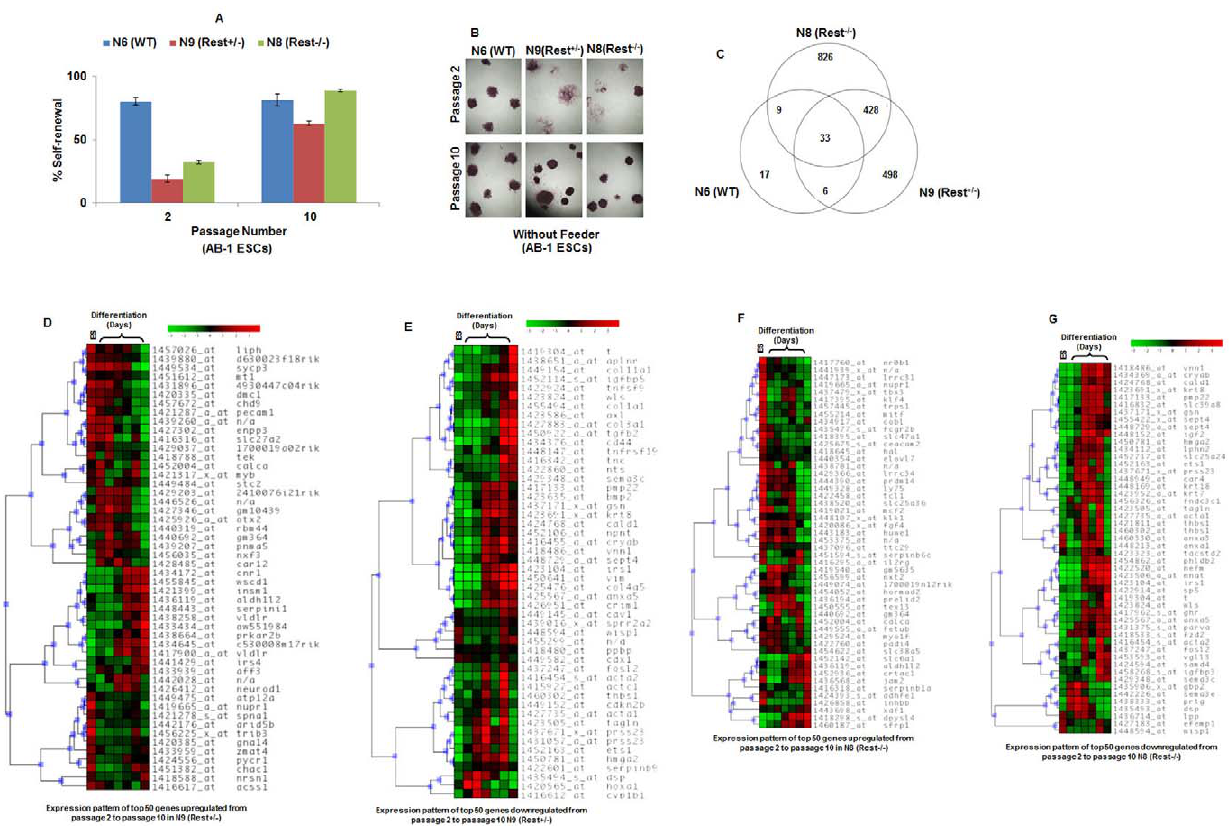
Figure 1. Rest + / 2 and Rest 2 / 2 AB-1 ESCs cultured in the absence of feeder cells show impaired self-renewal that is restored upon prolonged culture. (A, B) Alkaline phosphatase based self-renewal assay shows that the self-renewal efficiency of the N9 (Rest + / 2 ) and N8 (Rest 2 / 2 ) ESCs was significantly lower than that of the parental AB-1 ESCs at passage 2 but not at passage 10. (A) quantification of self-renewal assays. (B) representative pictures of colonies from self-renewal assays. The numbers under the lines show p-values (n=3). Error bars are standard error of means. Cells were cultured in absence of feeder cells and in presence of LIF. (C) Venn diagram showing comparison of genes that showed a significant change in expression during the transition between passage 2 and passage 10 by genome-wide expression profiling. N9 (Rest + / 2 ) and N8 (Rest 2 / 2 ) cells showed significant changes in gene expression (N9 , 965 and N8 , 1296) compared to WT cells ( , 65). (D, E, F and G) Heat map showing comparison of 50 genes with the highest fold changes that were either (D and F) up-regulated or (E and G) down-regulated in Rest + / 2 and Rest 2 / 2 cells during the transition from passage 2 to passage 10 to the expression of these genes in ES and differentiating cells based on FunGenES database. (Figure 1D and Figure 1F, see Table S3), whereas the down- regulated genes corresponded mostly to genes expressed in differentiating embryoid bodies (EB6) [similarly, the concordancy is 46 out of 50; P =3.30E-13 for N9 (Rest + / 2 ) and 45 out of 50; P =4.12E-12 for N8 (Rest 2 / 2 )] (Figure 1E and Figure 1G, see Table S3). Thus, supporting the AP assays seen above, the genome-wide analysis using both IPA and FunGenES databases indicated that, while the wild-type cells showed similarity to pluripotent ESCs and remain unchanged from passage 2 to passage 10, the N9 (Rest + / 2 ) and N8 (Rest 2 / 2 ) cells showed more similarity to differentiating cells at passage 2 while they showed more similarity to self-renewing ESCs in passage 10.